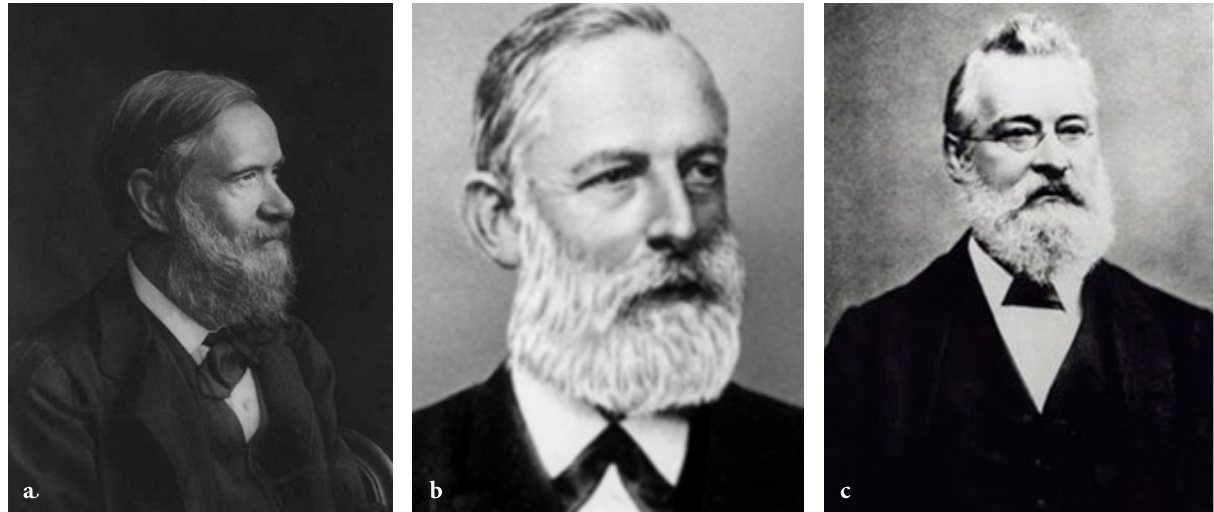
Figure 6. Mendeleev’s colleagues: Stanislao Cannizzaro (a); Julius Lothar Meyer (b); John Alexander Newlands (c) (photos from public